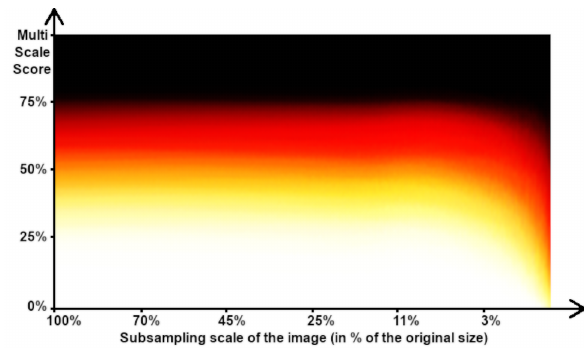
Figure 13. Multi-scale score of the 143 images corrected with the improved Wallis filtering.